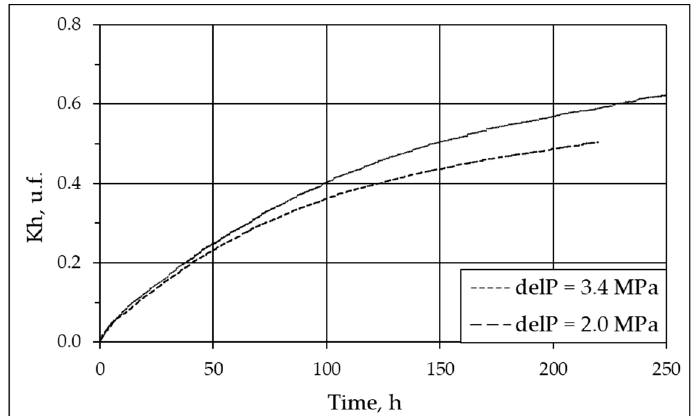
Figure 7. Time-dependent pore methane hydrate formation in sand 1 ( W = 15%, Si = 63%) at different excess pressures ( delP ) and at a constant temperature of − 3.8 ◦ C.